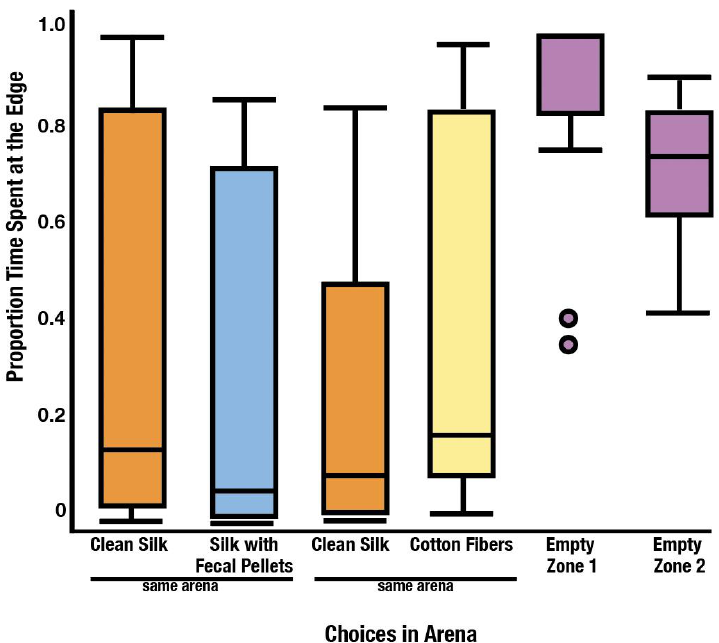
Figure 7. Box-and-whisker plots showing proportion of the time that individual adult E. myersi spent along the edges of arena walls. Clean silk and silk with fecal pellets were presented in different zones with two empty zones in the arena also as choices for each experiment ( n = 10). Clean silk and cotton wool fibers were presented at the same time also with two empty zones for a second experiment ( n = 9). Data from the empty zones that were presented along with the different substrates are combined, as the times along the walls in empty zones did not differ for these different experiments. Outliers are shown as purple circles.